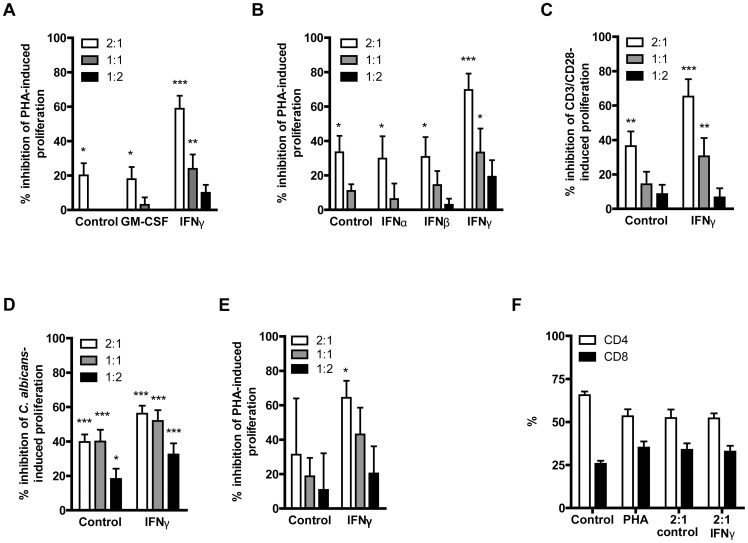
IFN-γ stimulated neutrophils suppress T-cell proliferation.(A) Neutrophils stimulated 18–20 hours with either GM-CSF or IFN-γ or left untreated and inhibition of PHA-induced PBMC proliferation was measured after 3 days. (B) Neutrophils stimulated 18–20 hours with IFN-α, IFN-β, IFN-γ or left untreated and inhibition of PHA-induced PBMC proliferation was measured after 3 days. (C) Neutrophils stimulated 18–20 hours with IFN-γ or left untreated and inhibition of CD3/CD28-induced PBMC proliferation was measured after 3 days. (D) Neutrophils stimulated 18–20 hours with IFN-γ or left untreated and inhibition of Candida albicans-induced proliferation was measured after 7 days. (E) CD16positive CD14negative CD3negative sorted neutrophils were stimulated 18–20 hours with IFN-γ or left untreated and inhibition of PHA-induced CD3positive CD14negative CD16negative sorted lymphocyte proliferation was measured after 3 days. (F) Percentage of CD4 and CD8 lymphocytes after 3 days PHA-induced PBMC proliferation in the presence of neutrophils stimulated 18–20 hours with IFN-γ or left untreated.